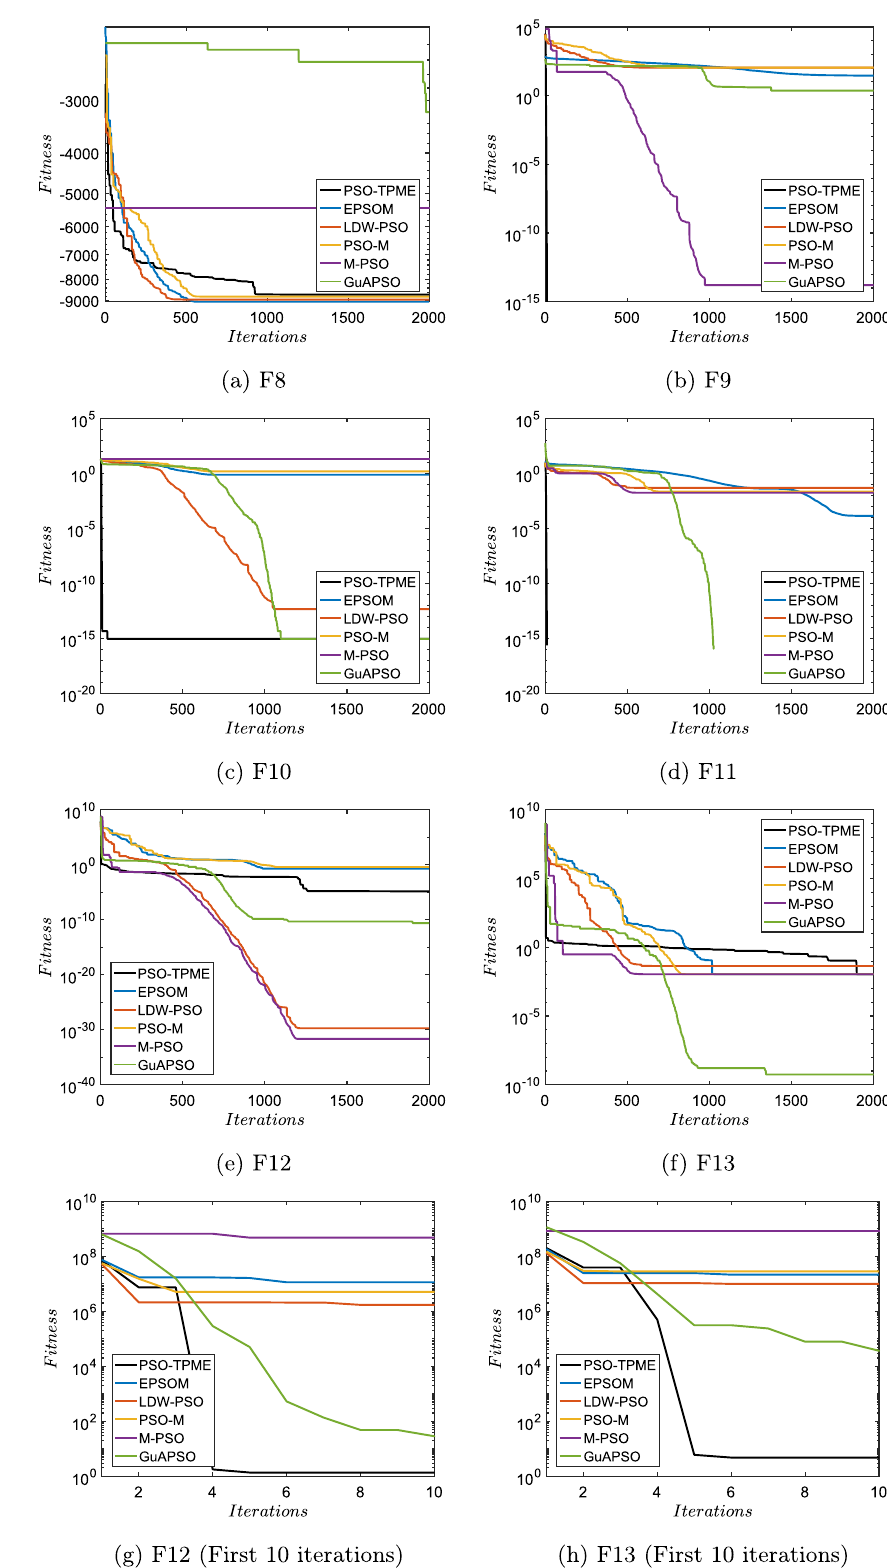
Fig. 5 Fitness performance of PSO variants on multi-dimen- sional benchmark functions. Figures a–f depict comparison of EPSOM, LDW-PSO, PSO- M, M-PSO, and GuAPSO with the proposed PSO on multi- modal 30-dimensional functions (F8 - F13). Figure g and h shows a zoomed-in plot of the first 10 iterations performance of the proposed PSO on F12 and F13,